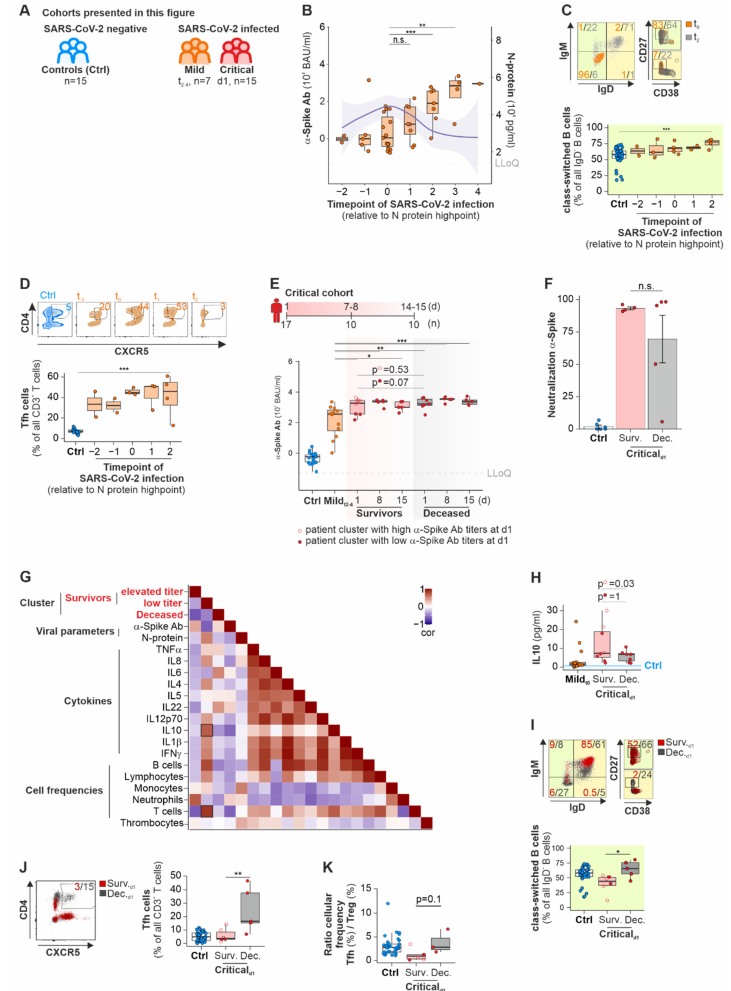
Figure 1. Dynamics of Ab titers against Wuhan SARS-CoV-2 Spike-protein in different COVID-19 disease stages in correlation of B and T cell maturation. ( A ) Scheme of patient cohorts and number of patients. ( B ) Development of α -Spike-Ab titers in SARS-CoV-2 infected patients with a mild disease course harmonized to the timepoint of highest N-protein concentrations (t 0 ) in sera. The shaded area indicates the 95% confidence interval of N-protein concentrations. ( C ) Representative dot plot (upper panel) and summarized box plot (lower panel) of B cells ( C ) in patients with mild SARS- CoV-2 disease course. ( D ) Representative contour plots (left panel) and summarized boxplot (right panel) of T follicular helper cells in mildly ill COVID-19 patients. ( E ) Titers of Wuhan α -Spike-Ab concentrations n sera of patients with a critical COVID-19 disease course; non-filled points show the cluster of patients with an increased Ab titer. ( F ) Neutralization capacity of the antibodies against the RBD of Spike protein in healthy non-vaccinated controls and critically ill patients. ( G ) Correlation plot of selected parameters of patients with a critical disease course on day 1 showing Pearson correlation. Bordered squares show significant correlations. ( H ) IL10 titers in sera of patients with critical disease course. ( I ) Flow cytometry data corresponding to ( D ) applied to the critical cohort; non-filled points show cluster of patients with increased Ab titer. ( J ) Representative dot plot (left panel) and quantitative boxplot (right panel) of T follicular helper cells in patients with a critical SARS-CoV-2 course; non-filled points show cluster of patients with increased Ab titer. ( K ) Ratio of the frequencies of T follicular helper cells to T regulatory cells (CD3 + CD4 + CD25 high CD127 − ); non-filled points show cluster of patients with increased Ab titer. Ctrl denotes a cohort of patients with similar symptoms but without a positive SARS-CoV-2 test. Blue line, mean concentration in healthy Ctrl; blue dashed line, 95% confidence interval; LLoQ, Lower Level of Quantification; Mann-Whitney U test, un-adjusted p -value (B, C, E, G, H, I, J); * p Val < 0.05, ** p Val < 0.01, *** p Val <